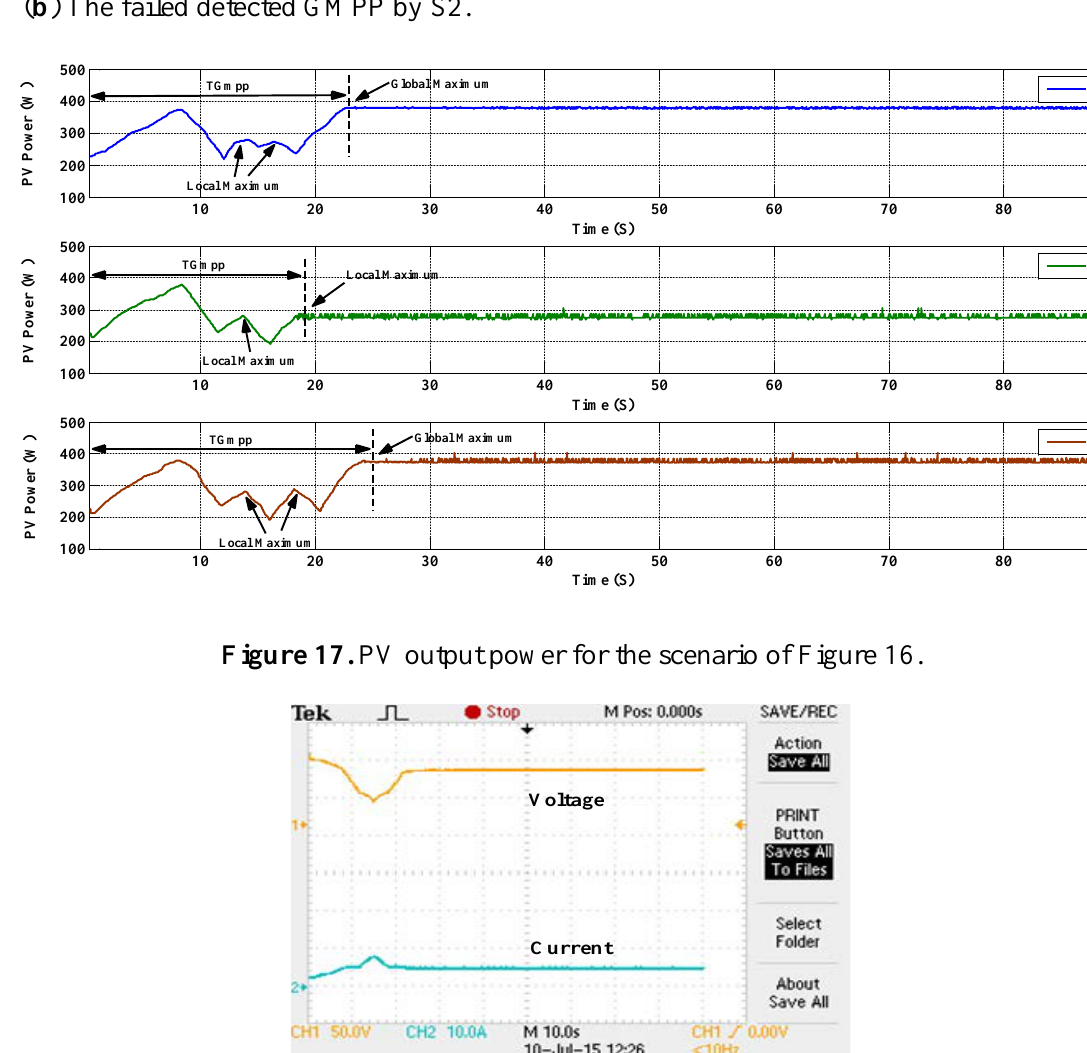
Figure 16. P - V and I - V curves under PSC ( a ) the detected GMPP by S1 and S3 and ( b ) The failed detected GMPP by S2.